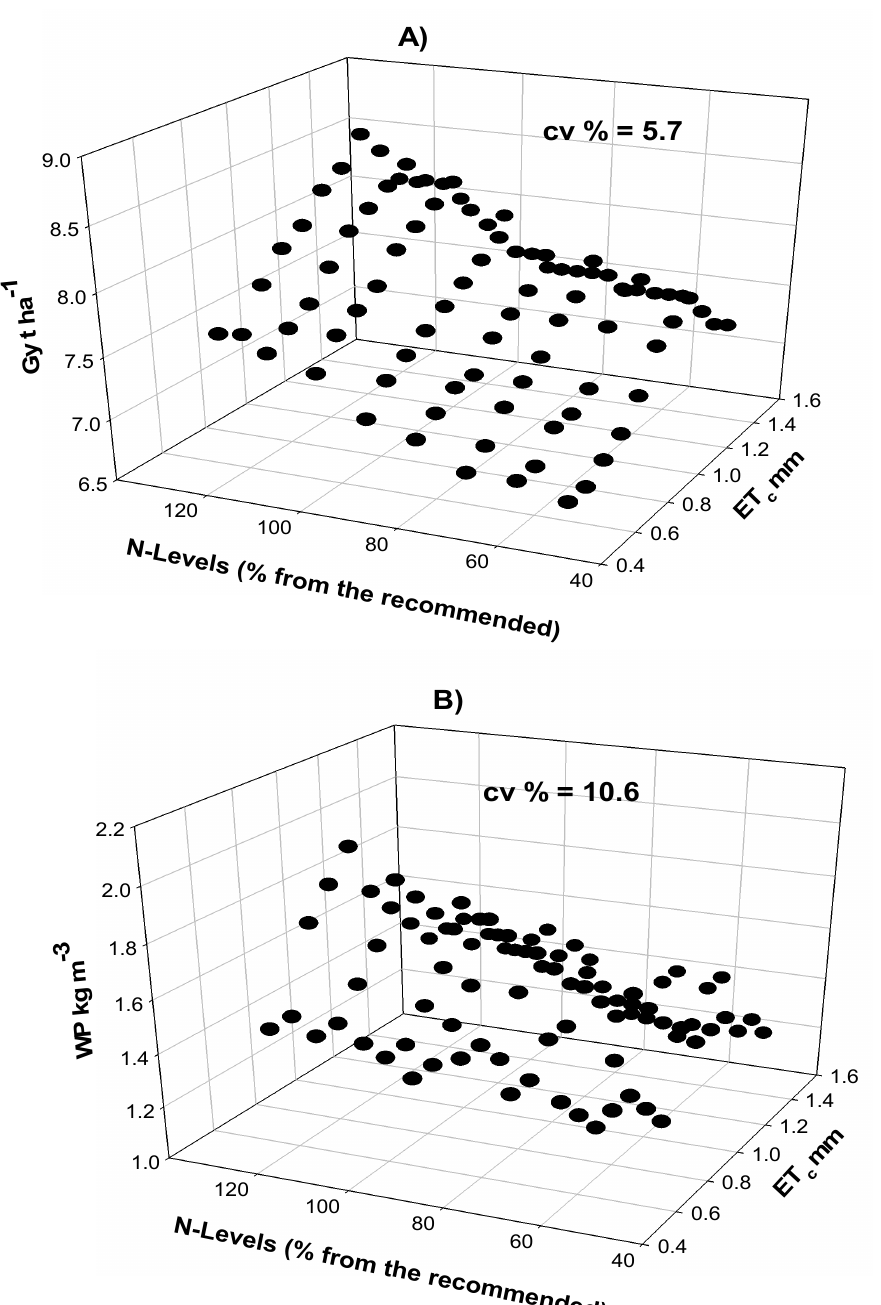
Figure 3. Simulated grain yield ( A ) and water use efficiency-based irrigation ( B ) as predicted by AQUACROP and APSIM subjected to different interactions between irrigation and N scenarios. Data were averaged over both models.